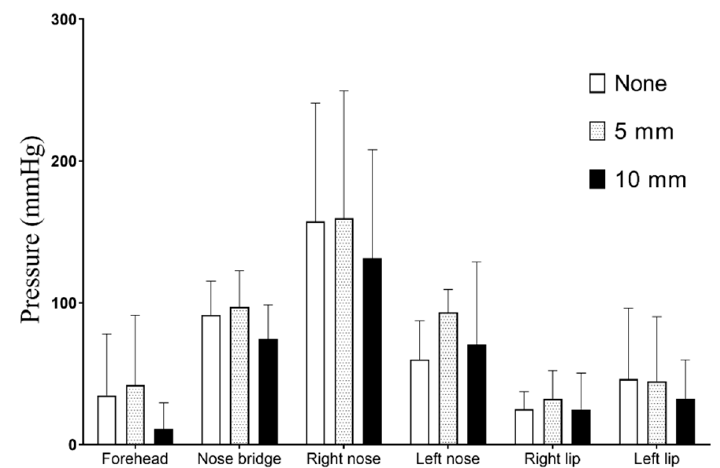
Figure 5. Average pressure applied to the face at each point.